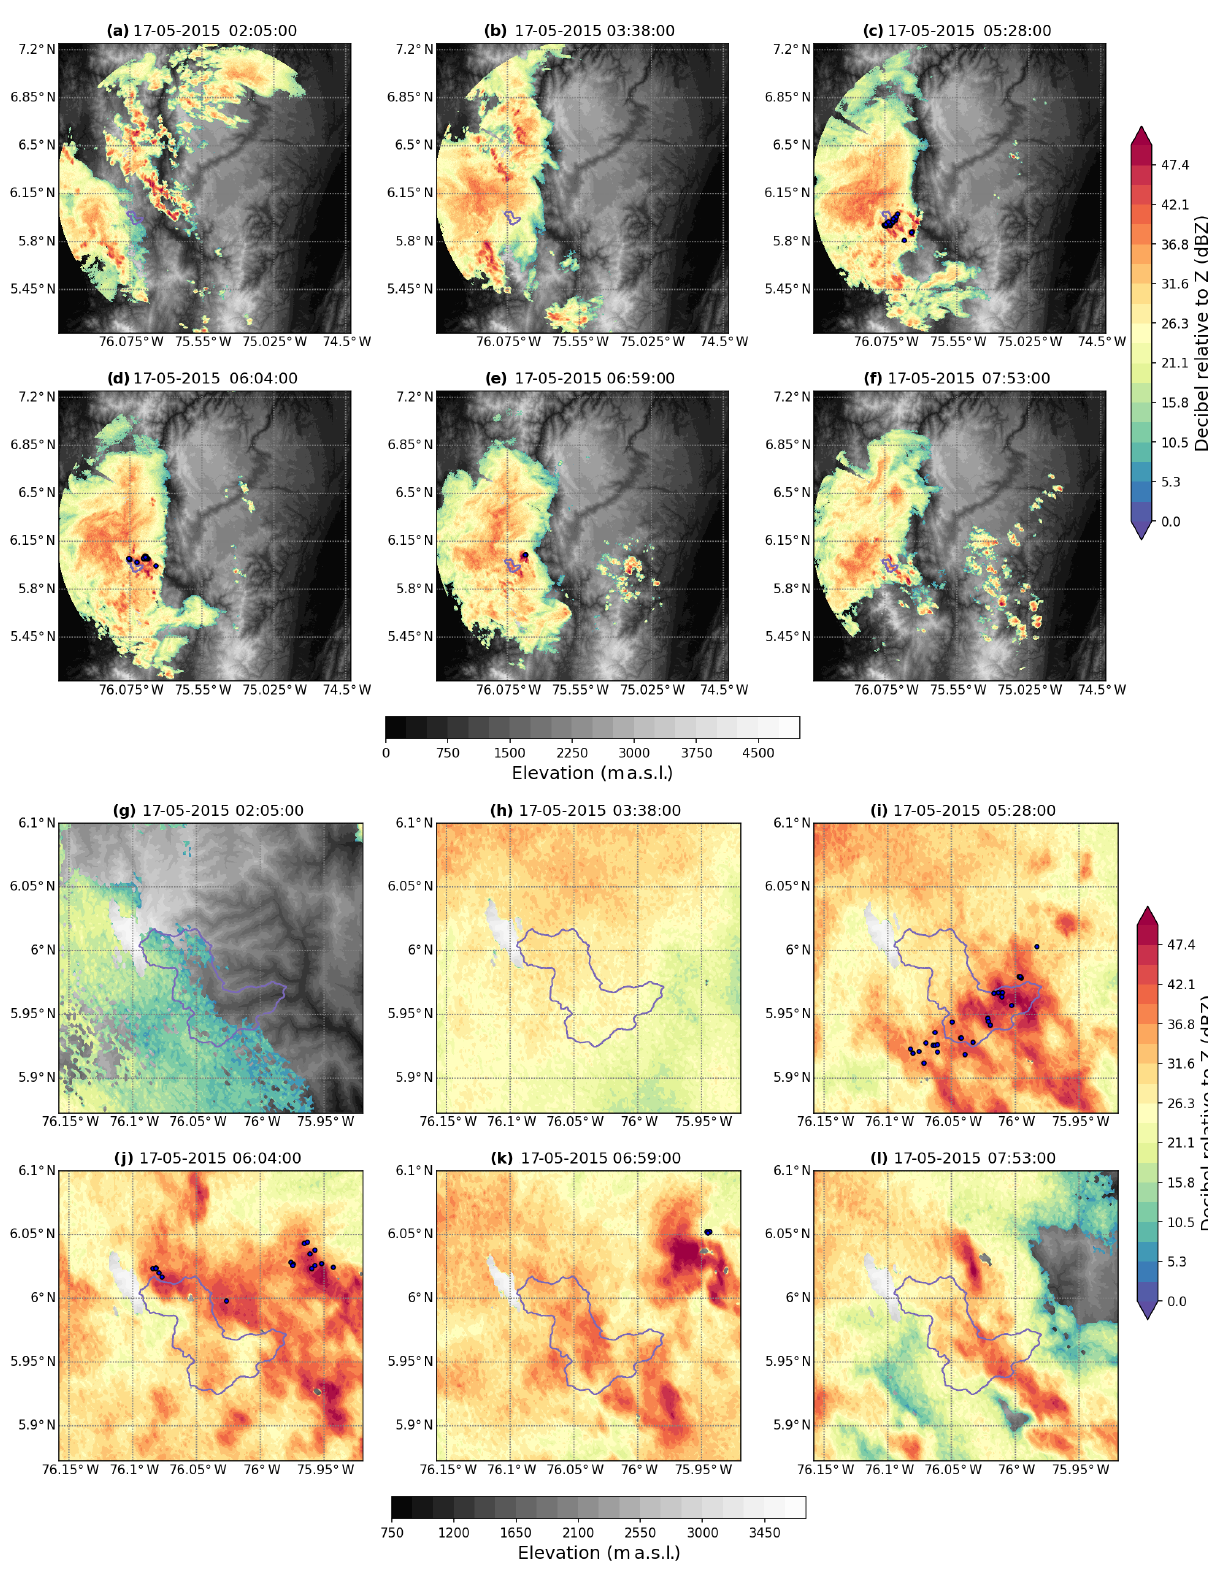
Figure 12. Quasi-horizontal reflectivity fields from the C-band radar (1 ◦ antenna tilt) showing the evolution of the 17 May precipitation event (period 2) for (a–f) the region determined by the 120km radius circular area centered at the radar site and (g–j) the region around the La Liboriana basin for the dates specified in each panel. The black dots correspond to cloud-to-ground